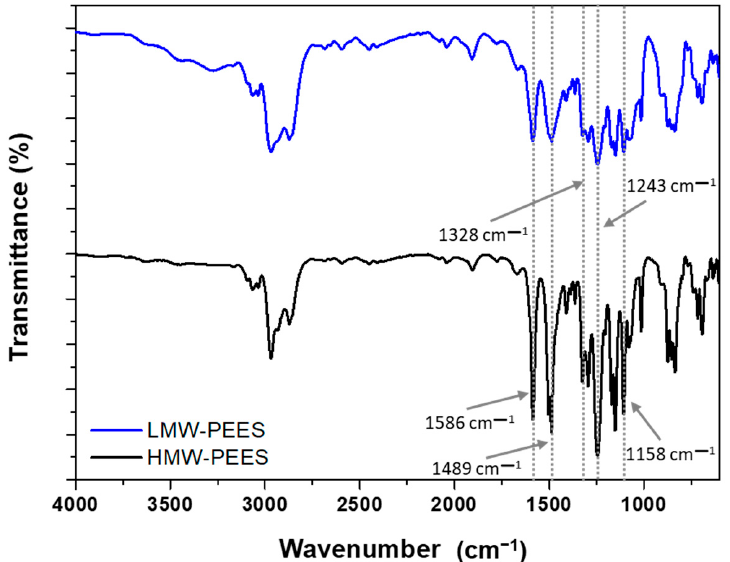
Figure 1. Infrared spectrum of PEES of high (HMW-PEES) and low (LMW-PEES) molecular weight.